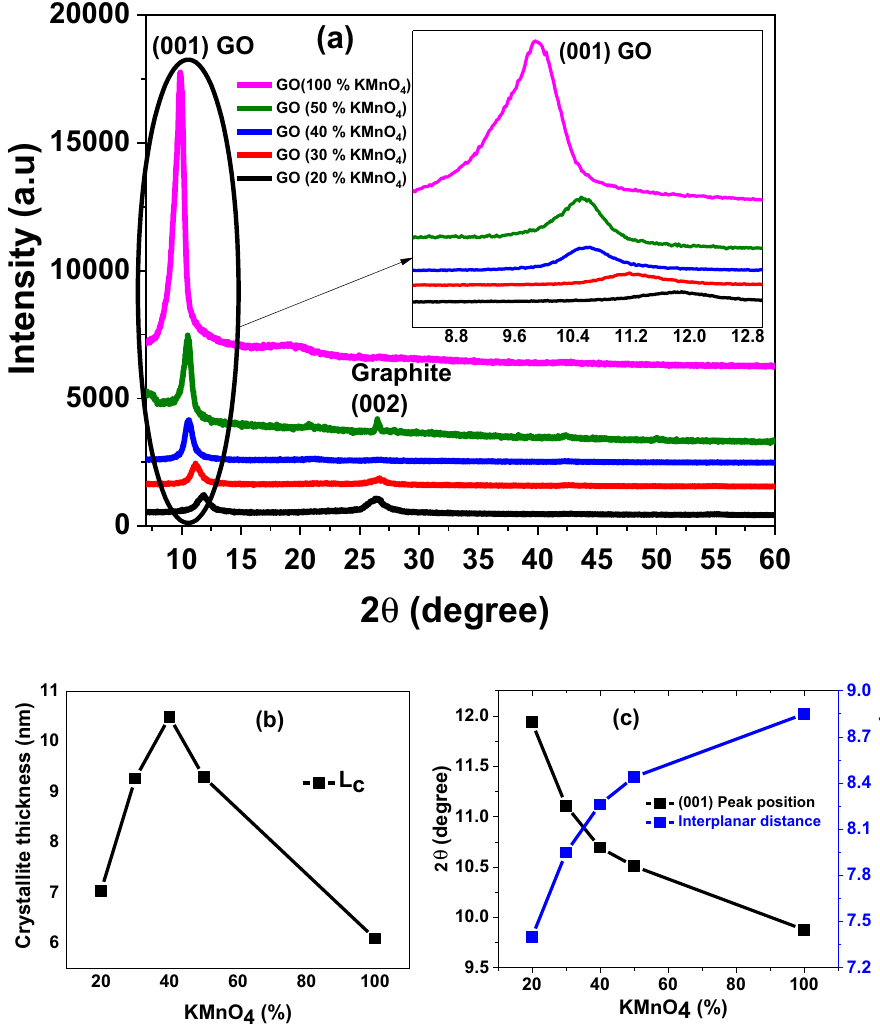
Figure 1. ( a ) XRD spectra of a series of controlled oxidized GO nanosheets samples with varying KMNO4 concentration ( b ) Crystallite height ( c ) Peak position of (001) plane and interplanar distances of controlled oxidized GO nanosheets